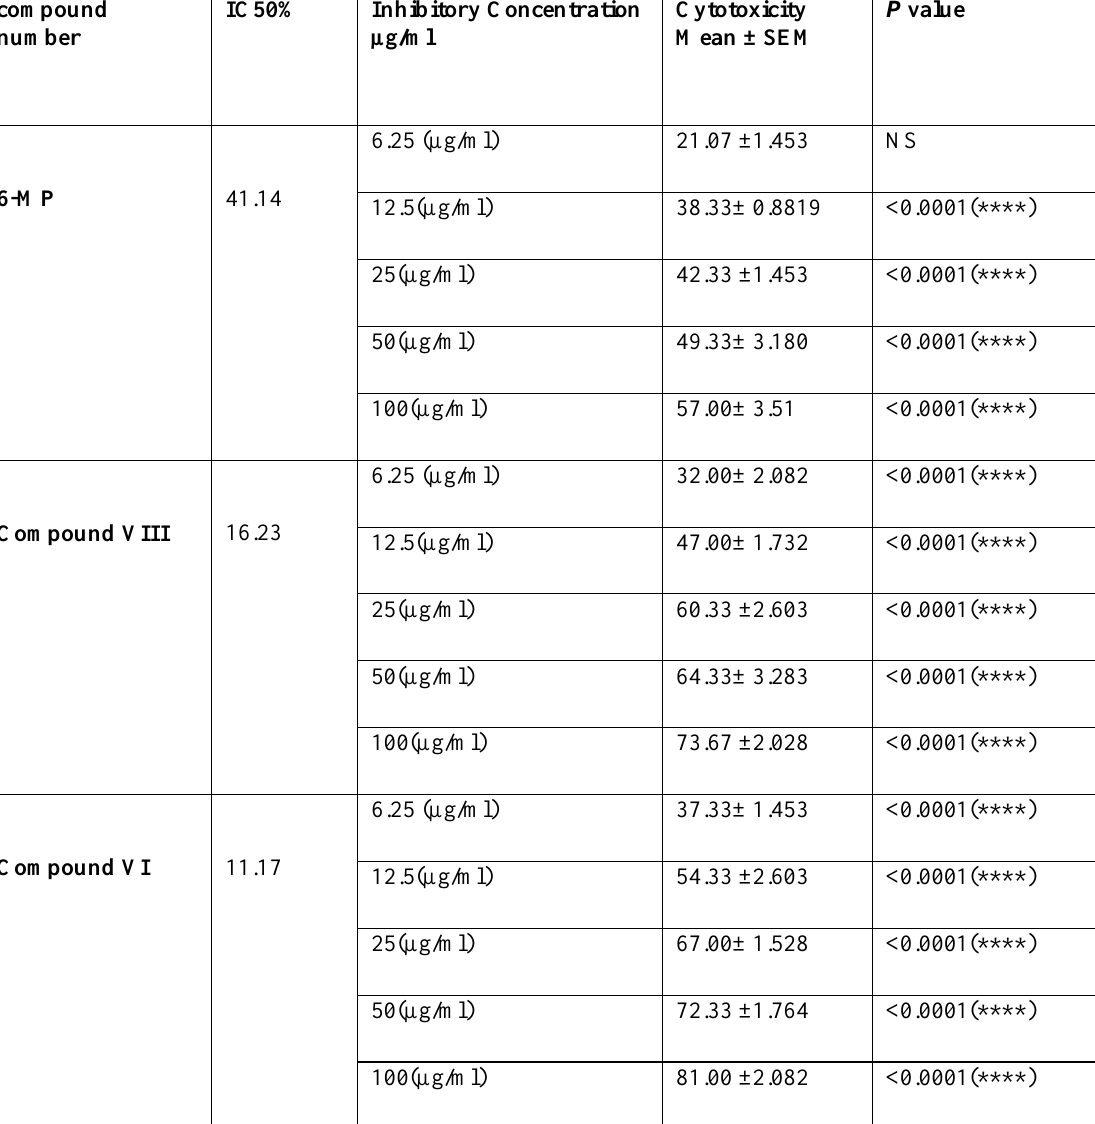
Table (2) Statistical results of cytotoxic activity of 6-MP, compound VIII and compound VI against SKO- 3 cancer cell (Mean ±SEM is mean and standard error of mean, P value is probability value, NS: